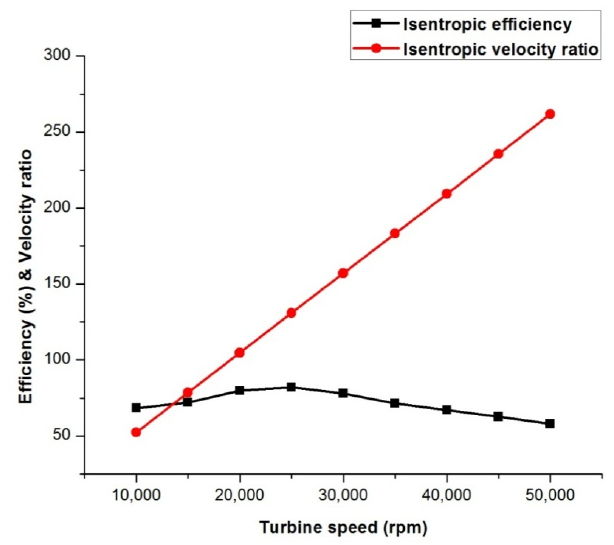
Figure 14. Variation of isentropic efficiency with isentropic velocity ratio and turbine speed.